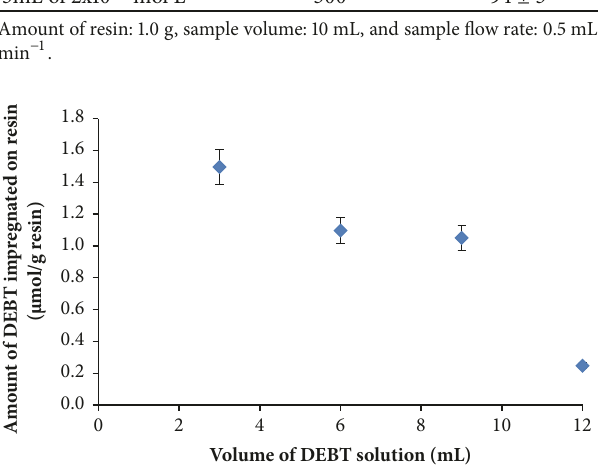
Figure 4: Effect of ligand volume on impregnation. Initial